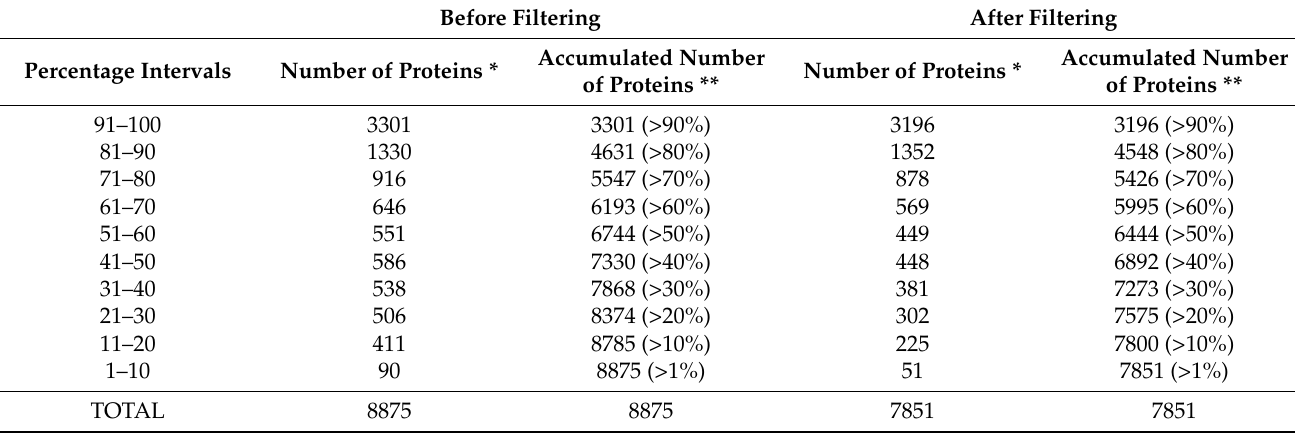
Table 3. The table lists the number of proteins from the Swiss Prot database on which the V. speciosa transcripts align along a percentage of their